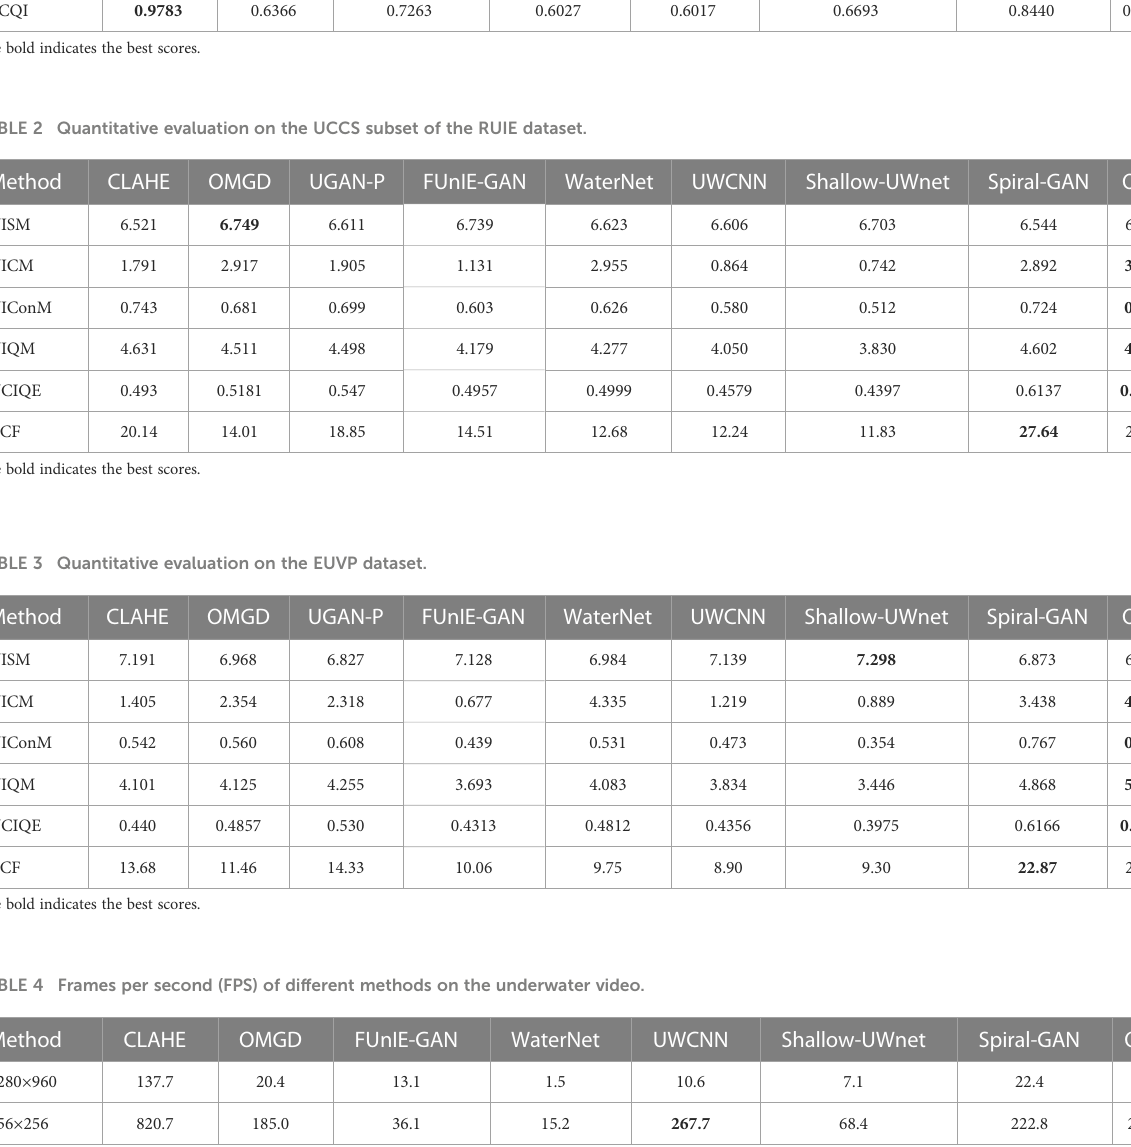
TABLE 2 Quantitative evaluation on the UCCS subset of the RUIE dataset.